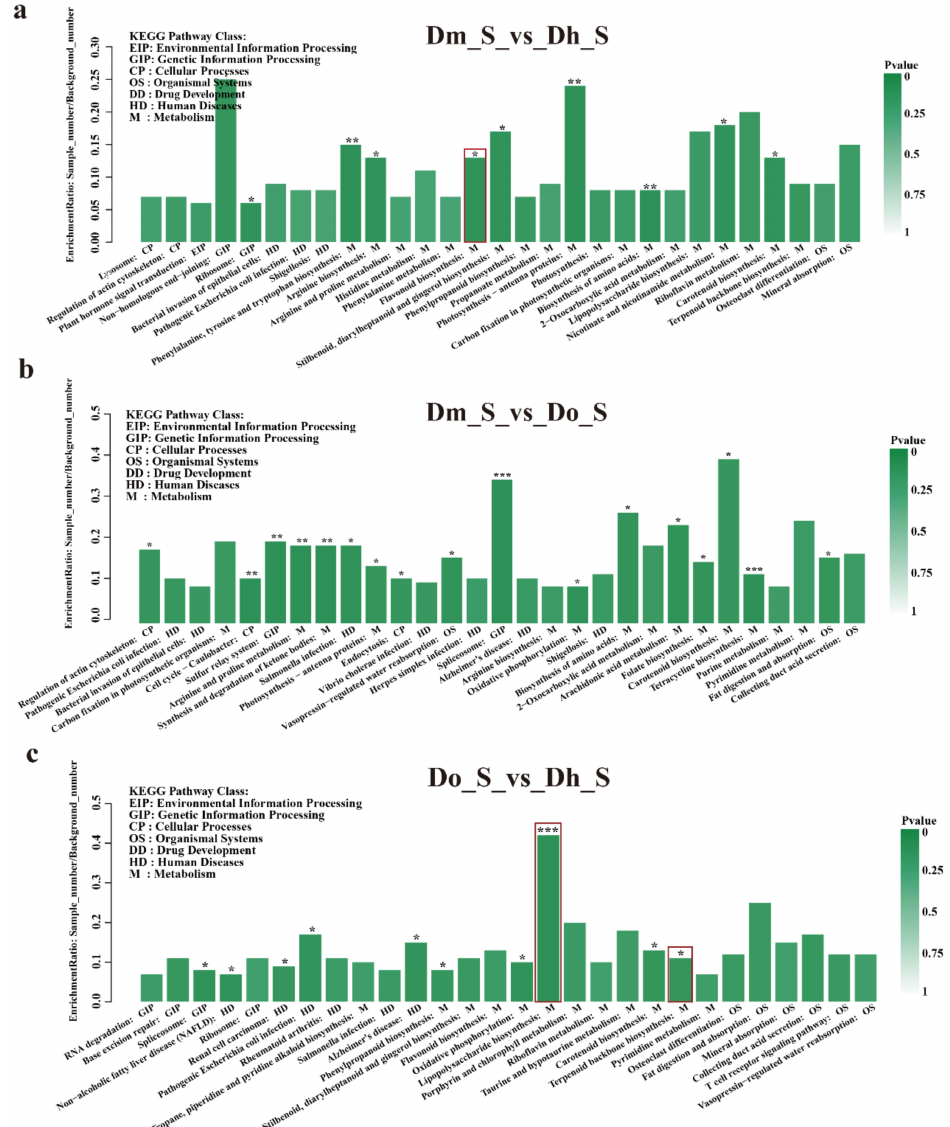
Figure 6. Kyoto Encyclopedia of Genes and Genomes (KEGG) pathway enrichment of DEGs. The x-axis representsthepathwayname, andthey-axisrepresentstheenrichmentratio(samplenumber / background number). ( a ) Dm_S vs. Dh_S; ( b ) Dm_S vs. Do_S; ( c ) Do_S vs. Dh_S. All pathways in the figure with asterisks indicate significant KEGG enrichment, with three asterisks indicating p -value < 0.001, two asterisks indicating p -value < 0.01, one asterisks indicating p -value <